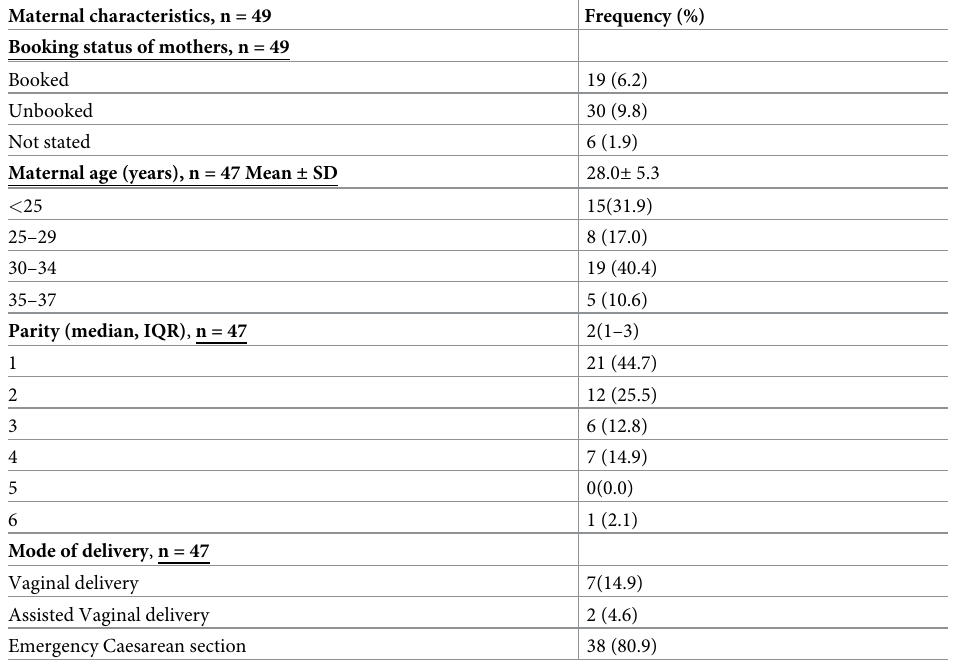
Table 2. Demographic and obstetrics characteristics of the mothers of inborn infants with